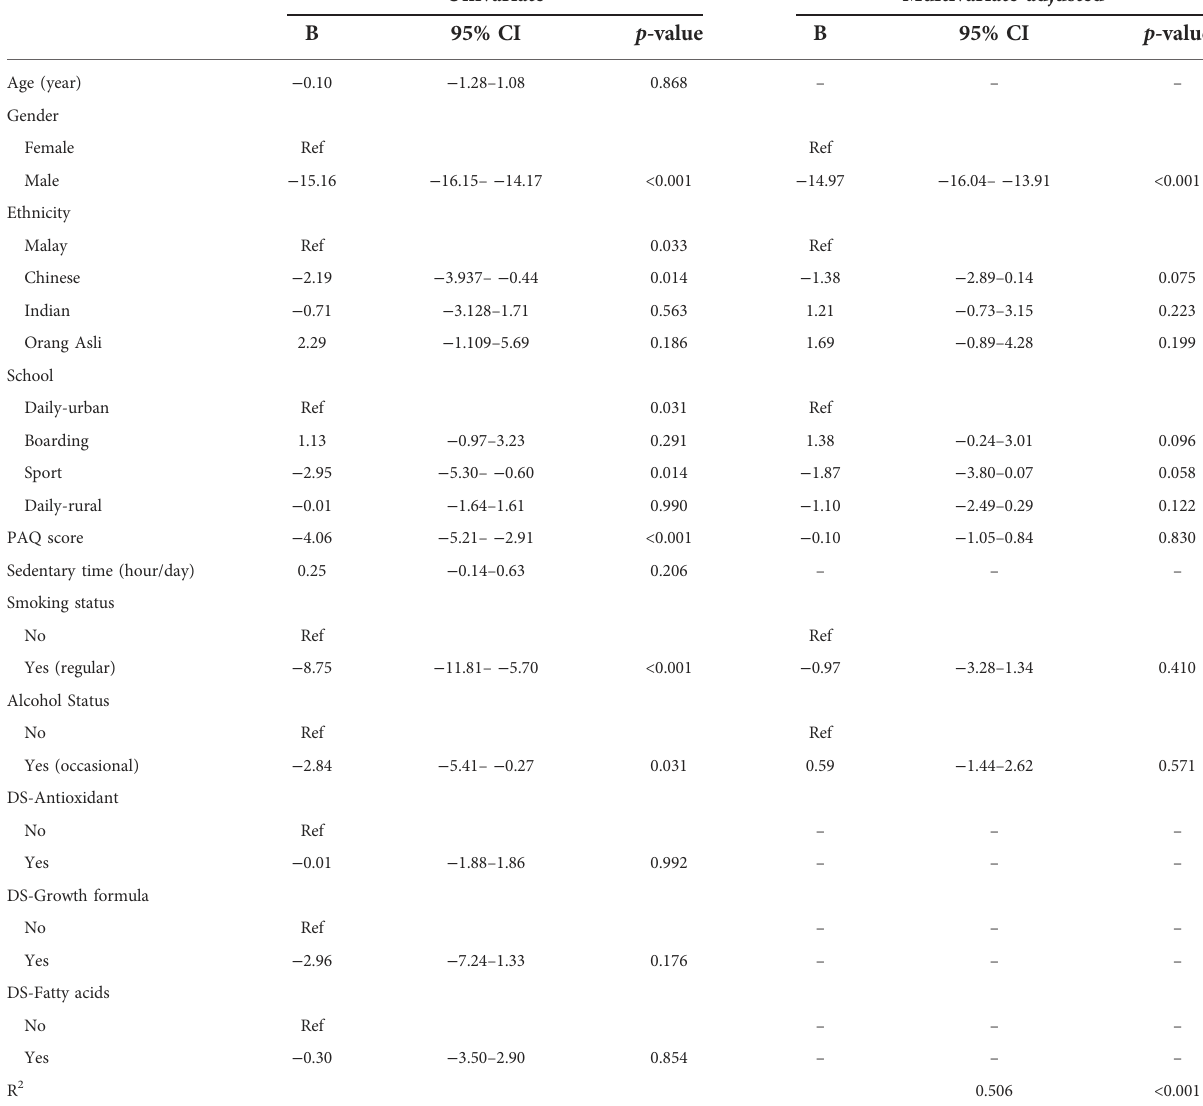
TABLE 4 Linear regression analyses for factors associated with body fat percentage ( n